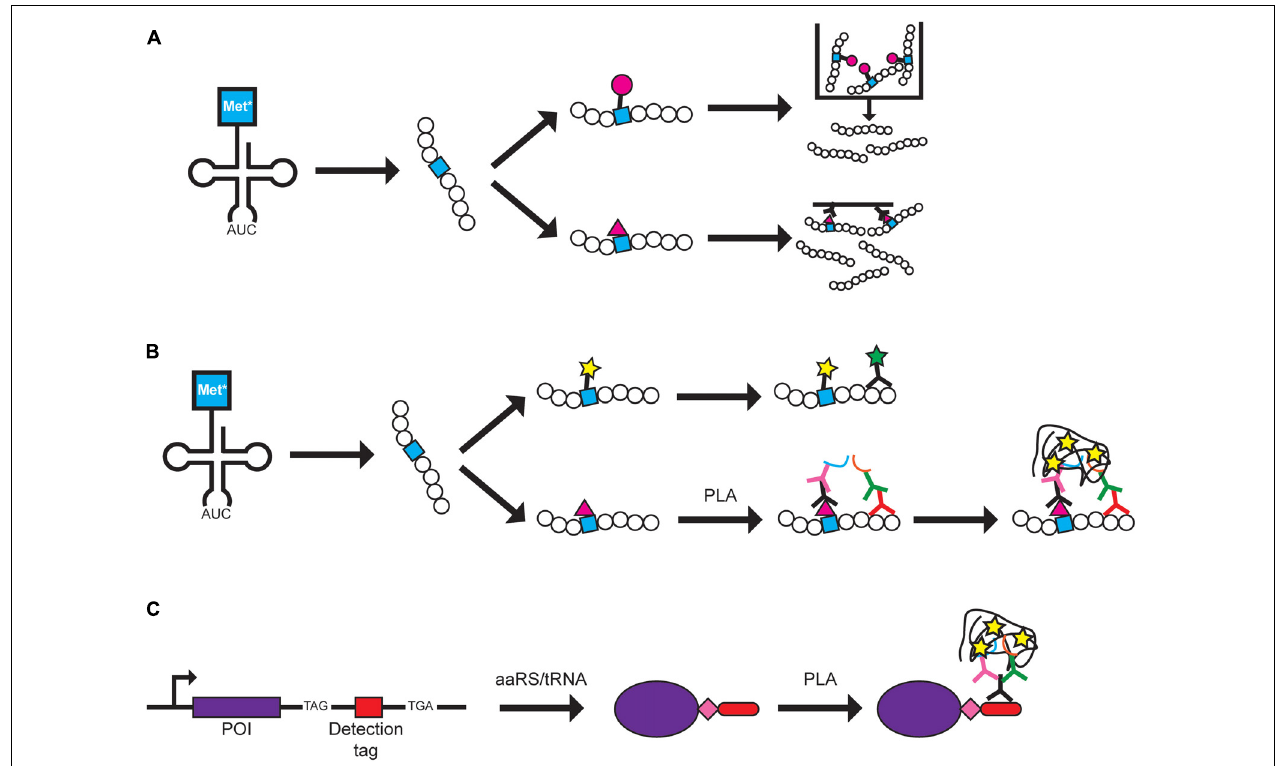
FIGURE 1 | Protein labeling methods using GCE. Examples of how BONCAT and FUNCAT can be used are shown. A Met analog (Met*) is charged onto tRNA Met by MetRS and is incorporated at Met codons. (A) In BONCAT, Met* can be directly conjugated to azide or alkyne-conjugated beads (pink circle) for purification (top pathway) or conjugated to azide or alkyne-conjugated biotin (pink triangle) for affinity purification (bottom pathway). (B) In FUNCAT, Met* can be fluorescently labeled via click chemistry and visualization of a specific protein can be achieved using a fluorescent antibody (top pathway). Alternatively, proximity ligation assay (PLA) can be performed by conjugating Met* to azide- or alkyne-conjugated biotin followed by addition of primary antibodies recognizing biotin and a specific protein. Separate secondary antibodies conjugated to DNA oligonucleotides (blue and orange lines) allow DNA rolling circle amplification that can be targeted by fluorescently labeled complementary probes for signal amplification (bottom pathway). (C) In SCROL, a labeling cassette containing a TAG stop codon, a detection tag (e.g., HA-tag and mCHERRY), and an alternative stop codon (e.g., TGA) are genomically incorporated at the 3 (cid:48) -end of the protein of interest (POI). Transfection of an orthogonal aaRS/tRNA pair and ncAA (pink diamond) produces a tagged protein that can be detected using PLA where a primary antibody targets the tag and two secondary antibodies target different parts of the primary